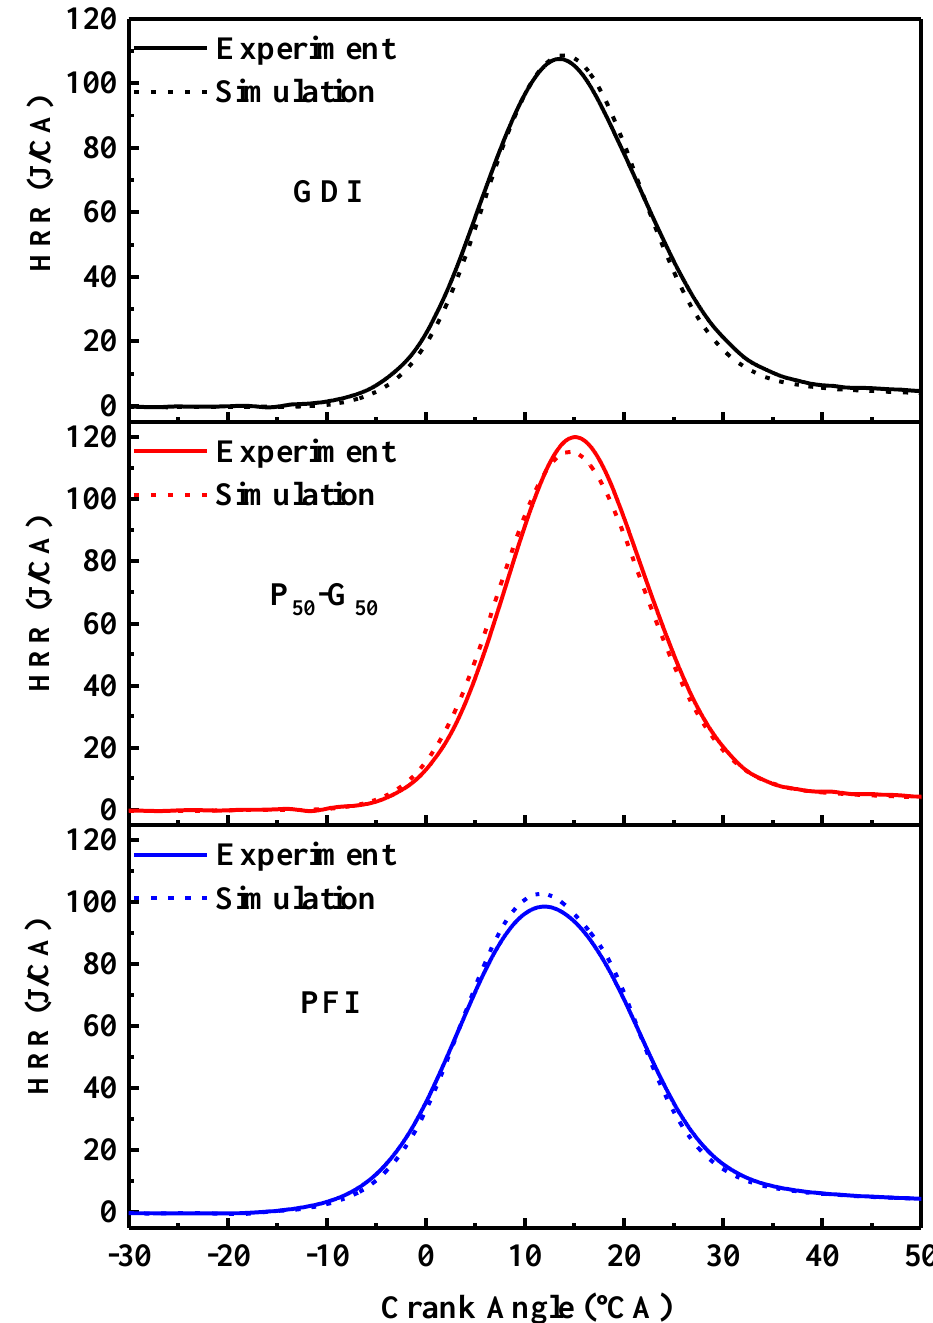
Figure 6. Comparison of HRR between experimental and simulation results at 2000 rpm-10 bar.